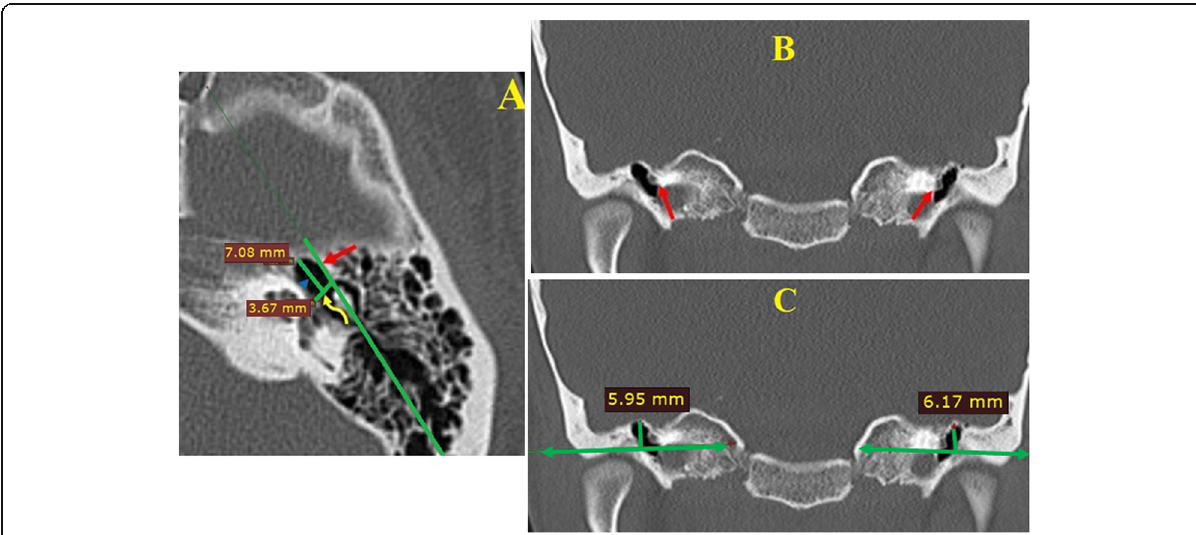
Fig. 2 Supratubal recess (STR) measurements. a Axial CT through the left STR, showing measurements of length (STR-L) and width (STR-W) of STR. STR-L: the deepest anterior to posterior diameter (arrowhead) parallel to incudomalleal axis (red arrow). STR-W: distance between medial and lateral borders of cog (curved yellow arrow). b , c Measurement of STR height (STR-H) in coronal CT, from tegmen tympani to the cochleariform process (red arrows), adjacent to the tensor tympani muscle. The cochleariform process separates the tensor tympani (hypoattenuating focus superolateral to the cochleariform process) from the bony Eustachian tube (inferomedially)